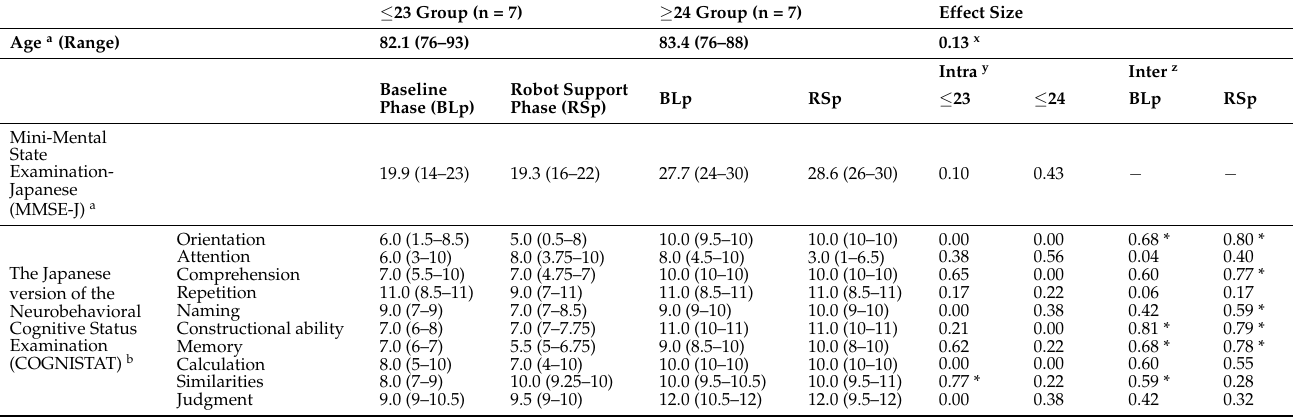
a = the scores represent average values and numbers in parentheses are ranges; b = the scores represent median values and numbers in parentheses are 25–75% quantile points; x, y, z = the effect size that resulted from attached t-test, Wilcoxon signed rank test, and Mann–Whitney’s U test, respectively; and * = p <